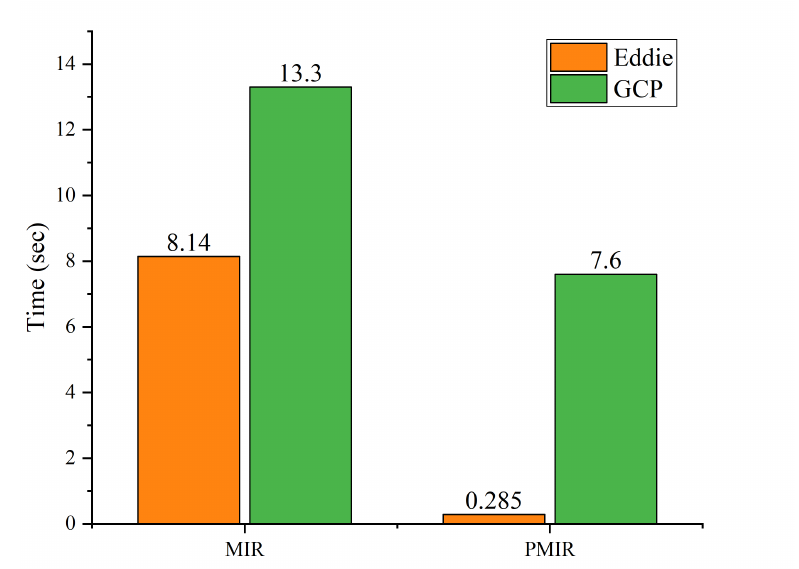
Figure 7. Execution time of MIR and parallel microwave image reconstruction (PMIR) algorithm on Eddie and Google Cloud Platform